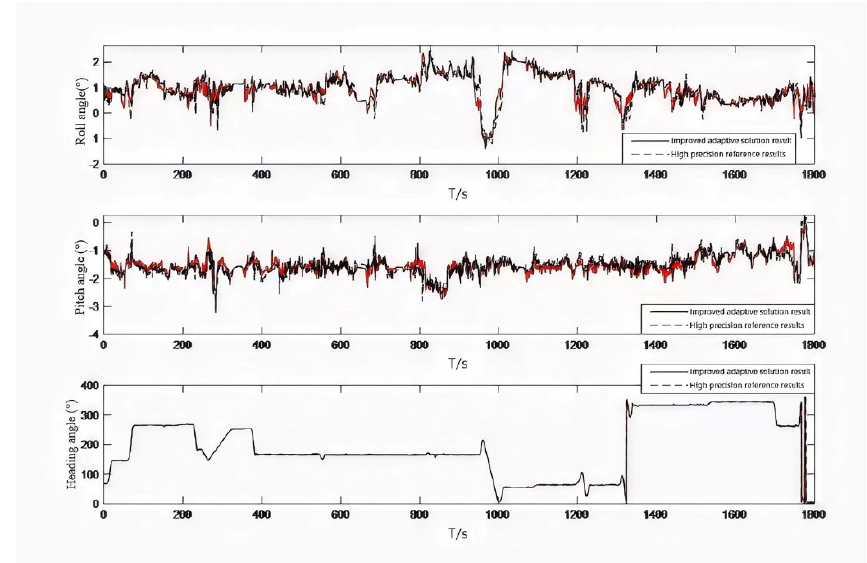
Figure 8. Comparison curve of attitude angle solution .